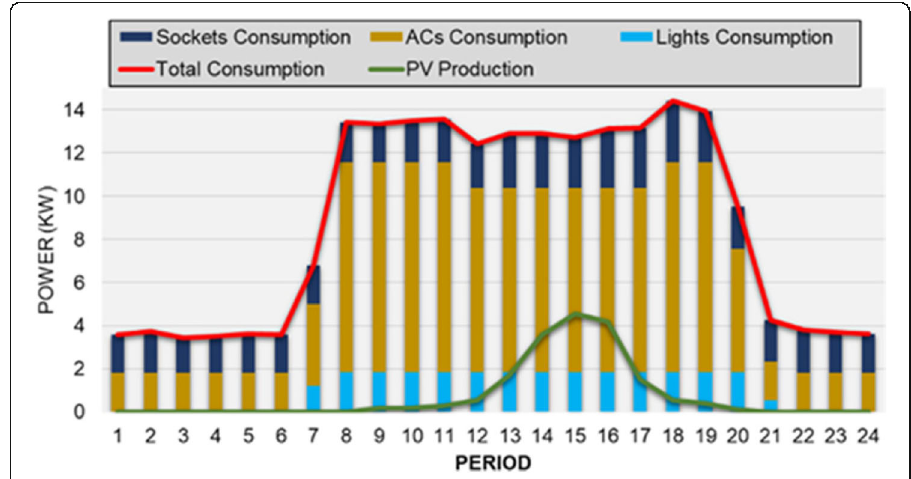
Fig. 6 Consumption and generation profiles of GECAD Building (BUS